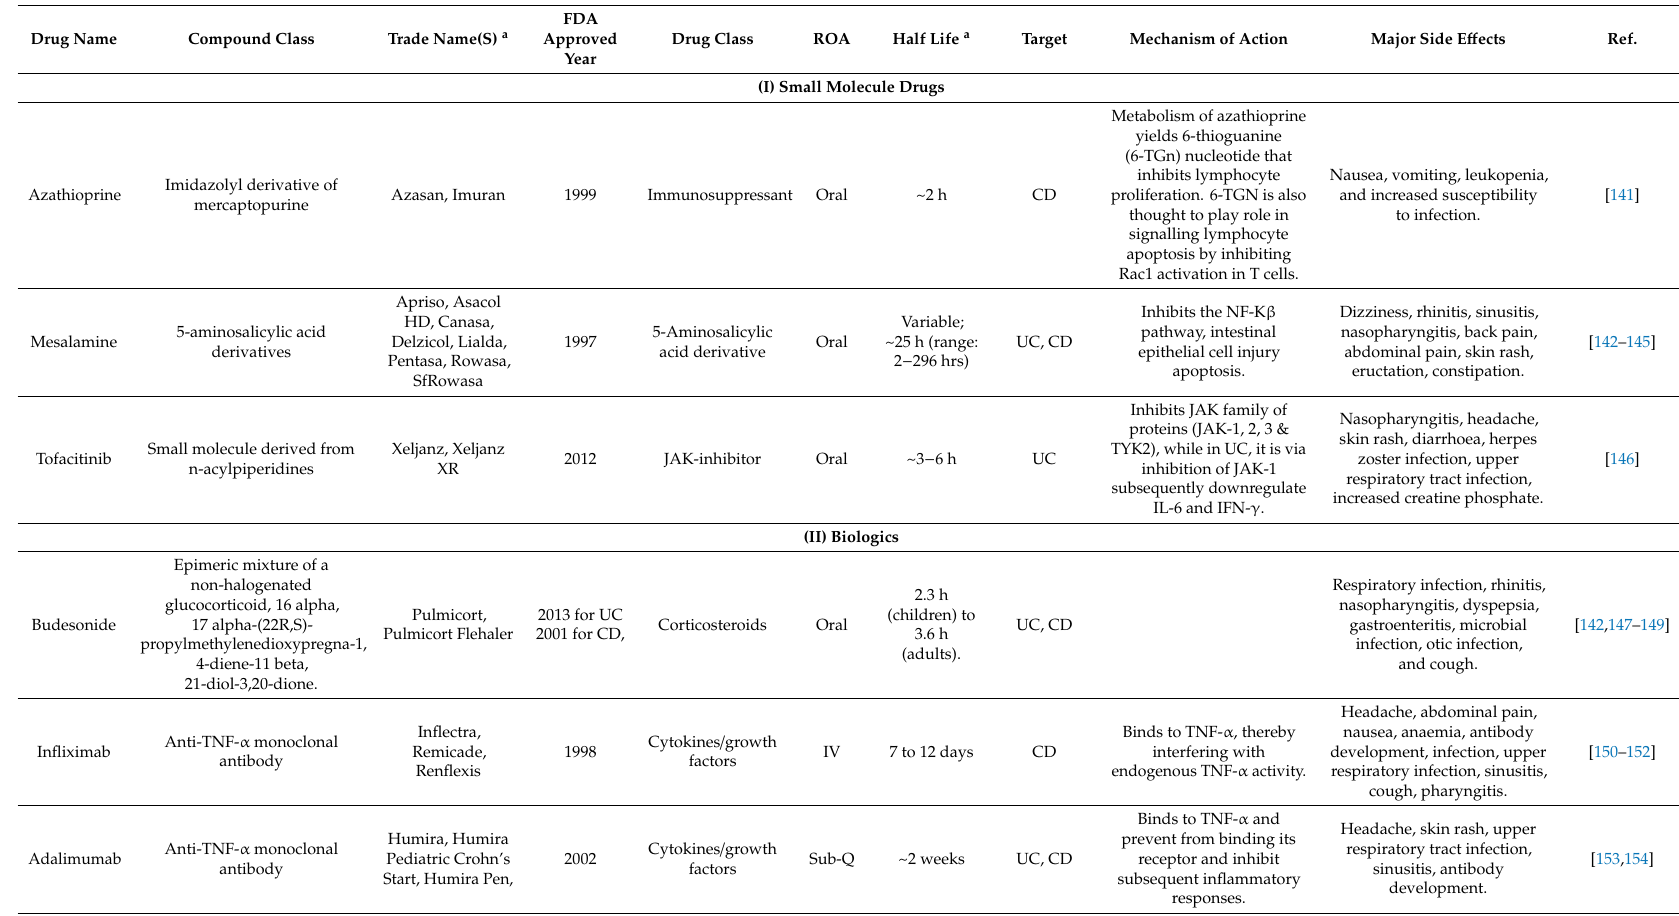
Table 1. Current drugs for inflammatory bowel